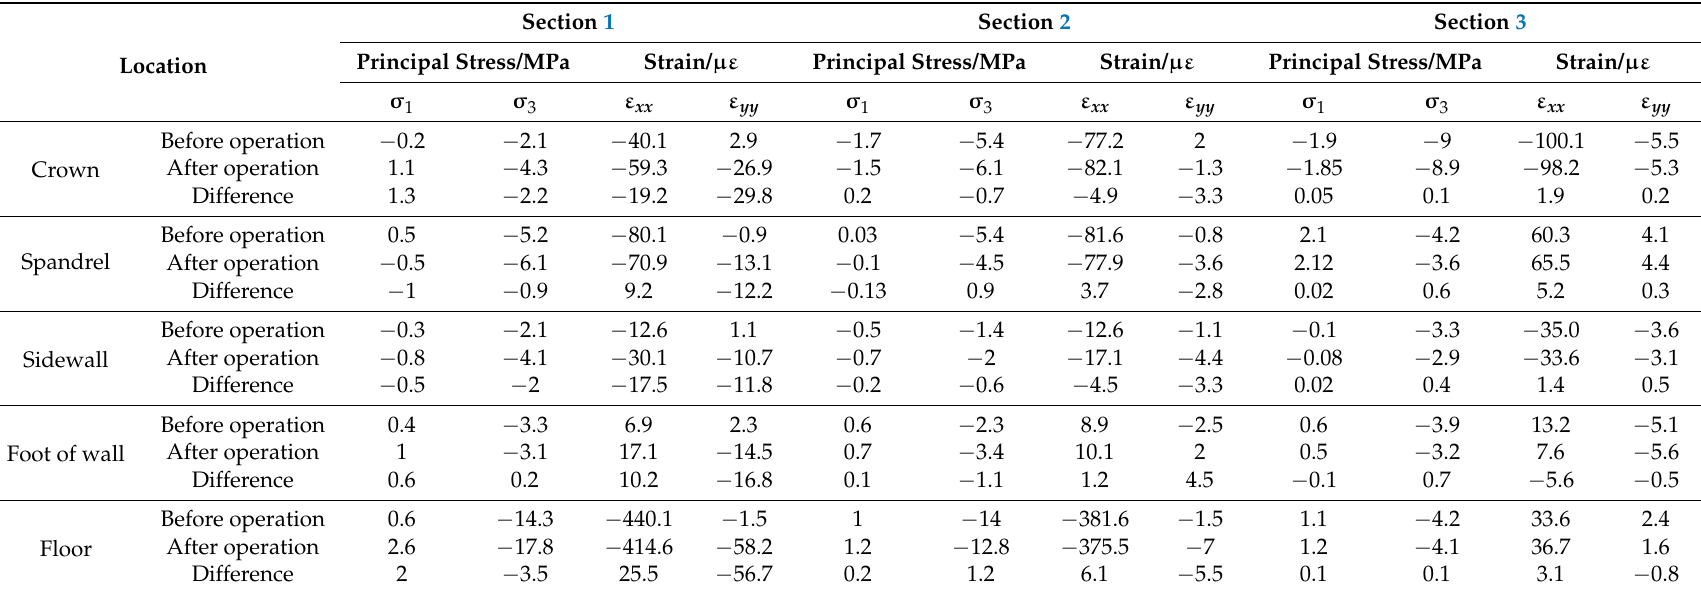
Table 4. Stress and strain situation of each control section before and after